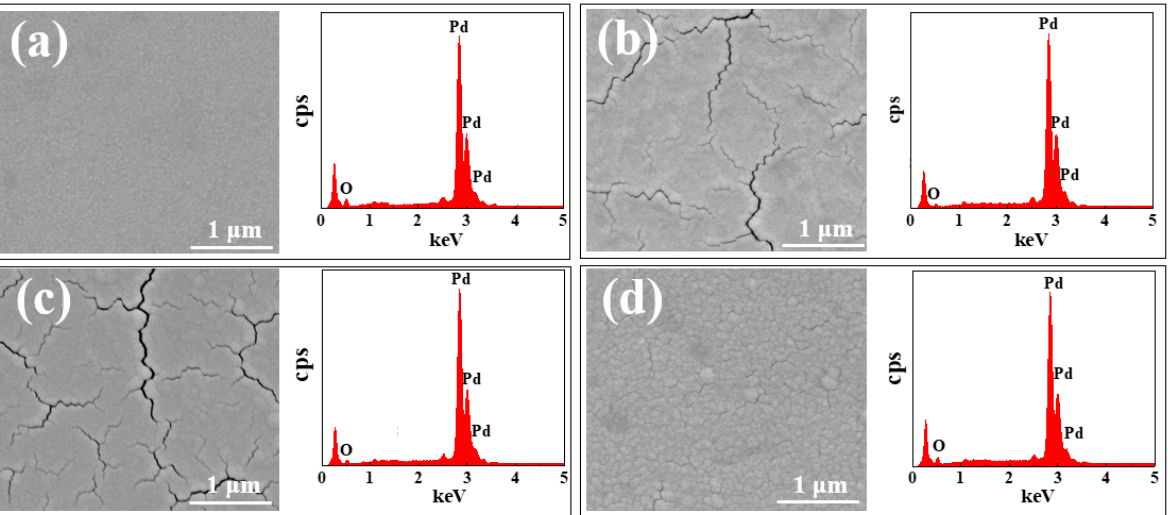
Figure 2. ( a – d ) Surface SEM and EDS images of films deposited at different sputtering pressures: